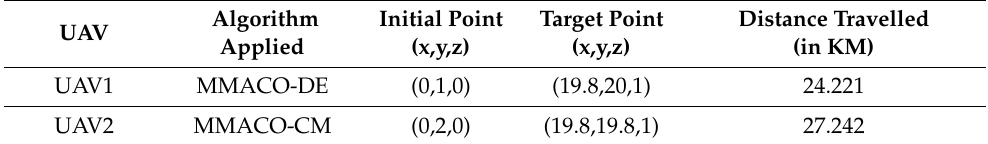
Table 4. Case 2 initial and target points.